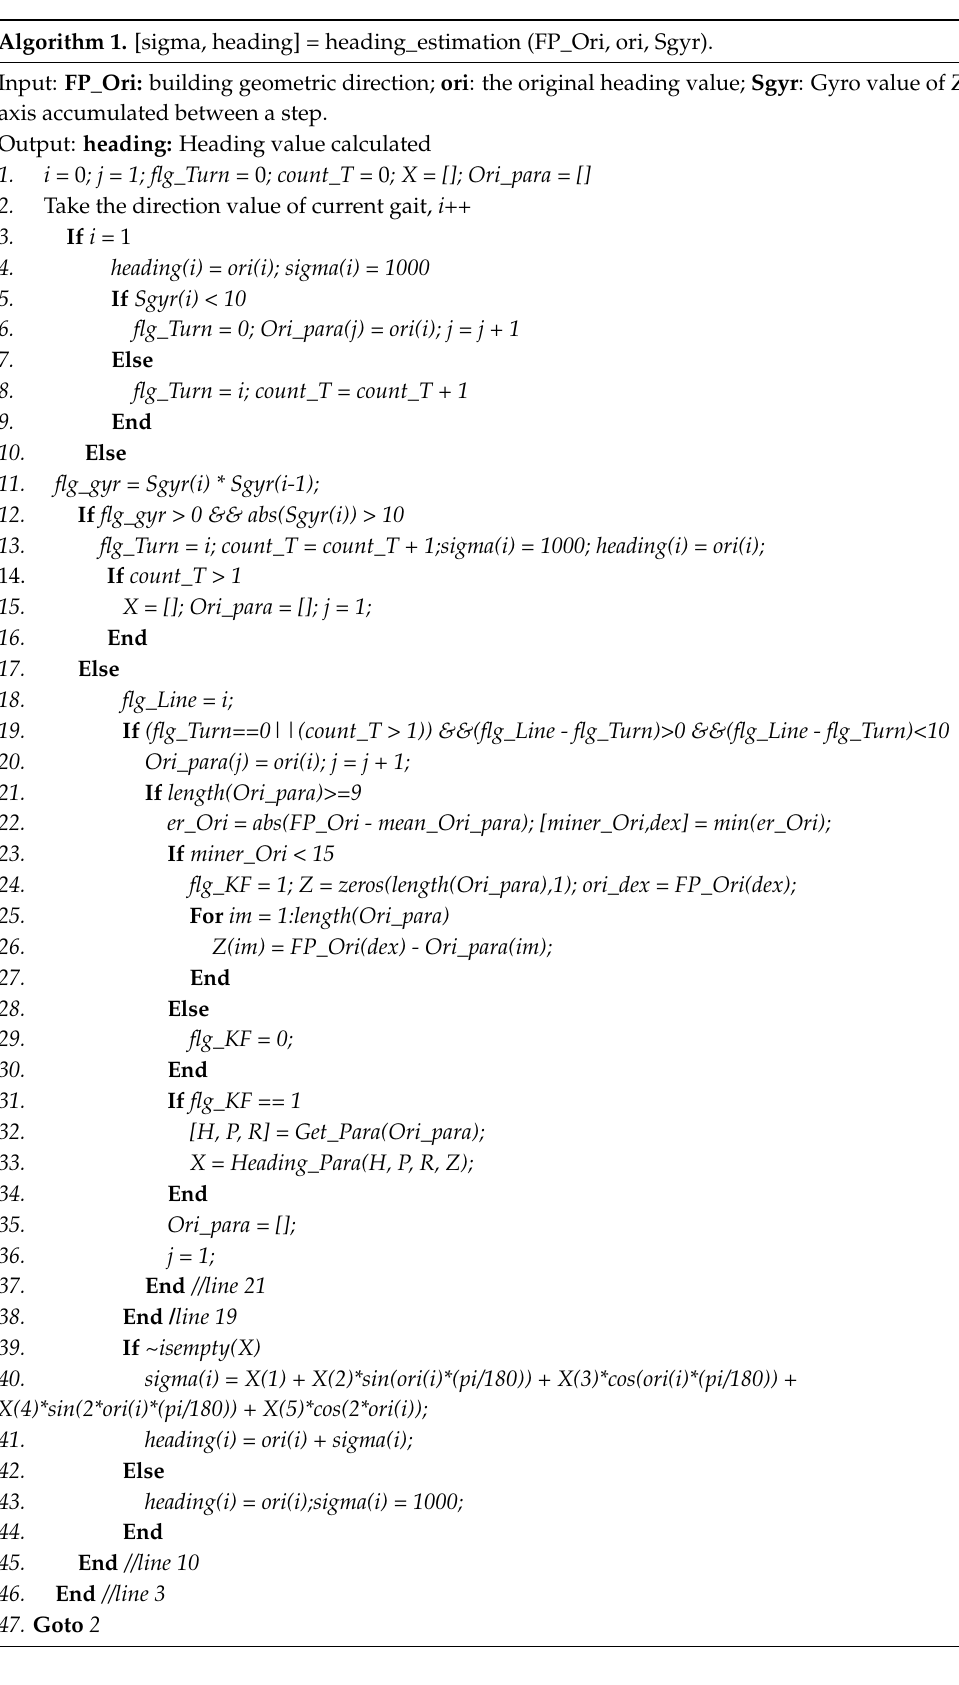
Algorithm 1. [sigma, heading] = heading_estimation (FP_Ori, ori,